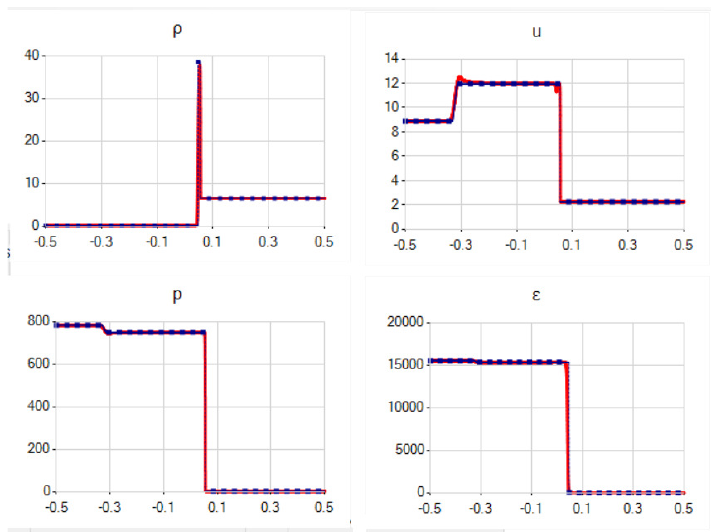
Figure 5. Test 4. Solutions for α = 0 . 2, β = 0 . 2 and N =